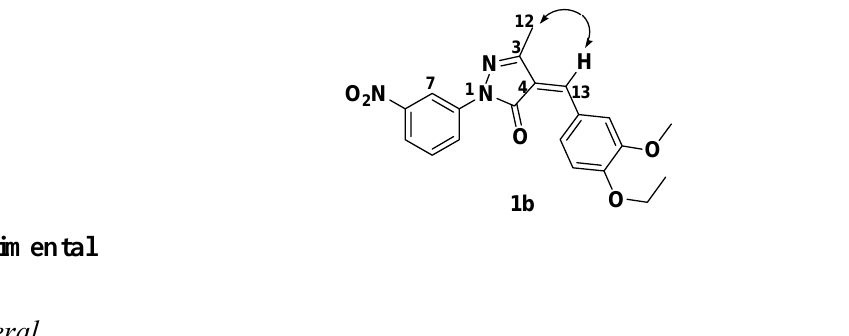
double bond in 1b